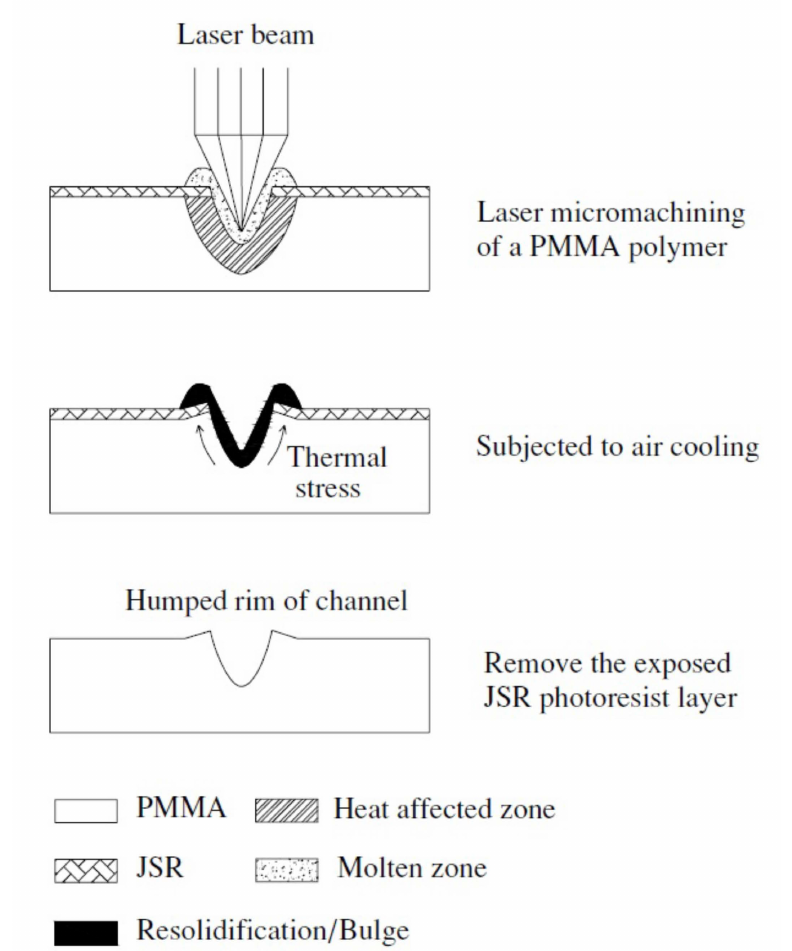
Figure 2. The schematic model of the bulge/hump formation mechanism in the laser machined PMMA with an exposed JSR photoresist cover